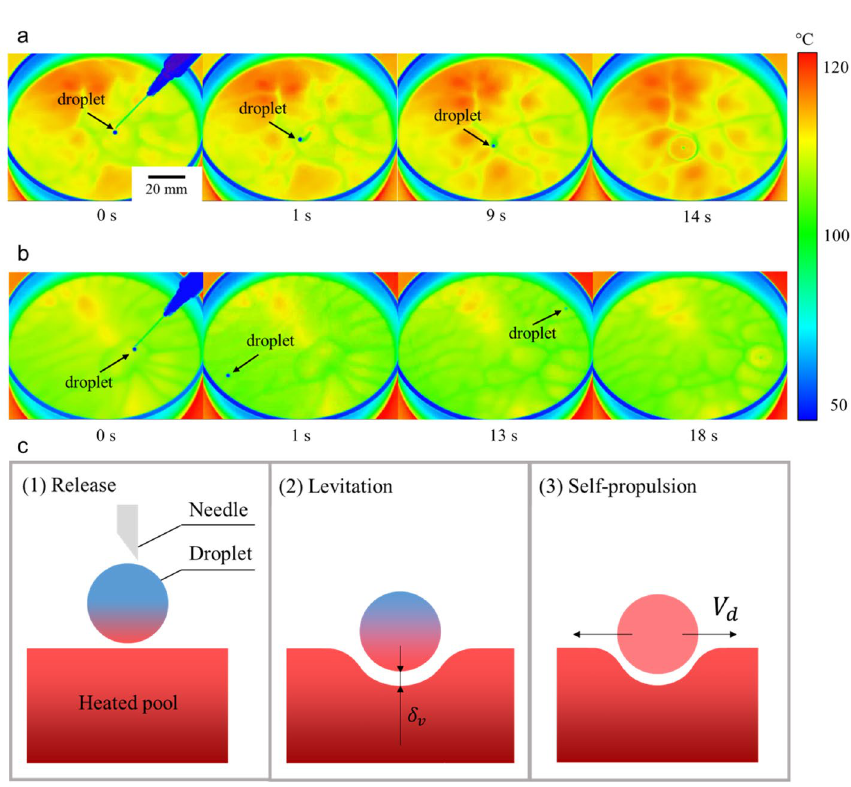
Figure 1. Droplet behaviour on heated pool. Snapshots of the temperature field obtained by an IR camera for ( a ) acetone droplet and ( b ) ethanol droplet. The droplet diameter was 2 mm. The acetone and ethanol droplets settled on the surface of the pool after approximately 14 s and 18 s, respectively. This information is also supported by Supplementary Videos 1 and 2. ( c ) Illustration of the droplet behaviour on the heated